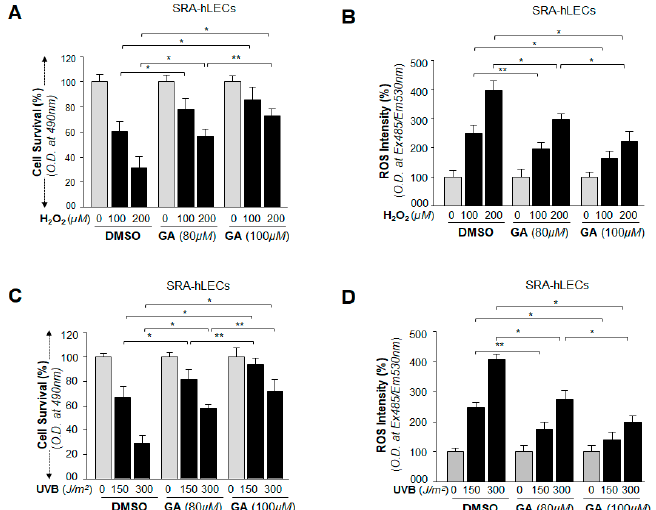
Figure 11. GA application protected LECs by blunting oxidative stress-mediated adverse signaling. ( A , B ) SRA-hLECs were pretreated with GA. Cells were washed and replaced 6 h later in Dulbecco’s modified Eagle’s medium (DMEM) (serum free) media containing the different concentrations of H 2 O 2 as indicated. 3-(4,5-dimethylthiazol-2-yl)-5-(3-carboxymethoxyphenyl)-2 to 4-sulphophenyl) 2H-tetrazolium salt; (MTS) (18 h) and ROS (8 h) intensity were measured. Data are the mean ± SD of three independent experiments. ** p < 0.05; * p < 0.001 versus control. ( C , D ) SRA-hLECs were pretreated with different concentrations of GA for 6 h; cells were washed and exposed to different doses of UVB as indicated. MTS assay ( C ) and ROS intensity ( D ) were quantified after 18 h and 8 h of UVB exposure, respectively. Data are the mean ± SD of three independent experiments. ** p < 0.05; * p < 0.001 versus